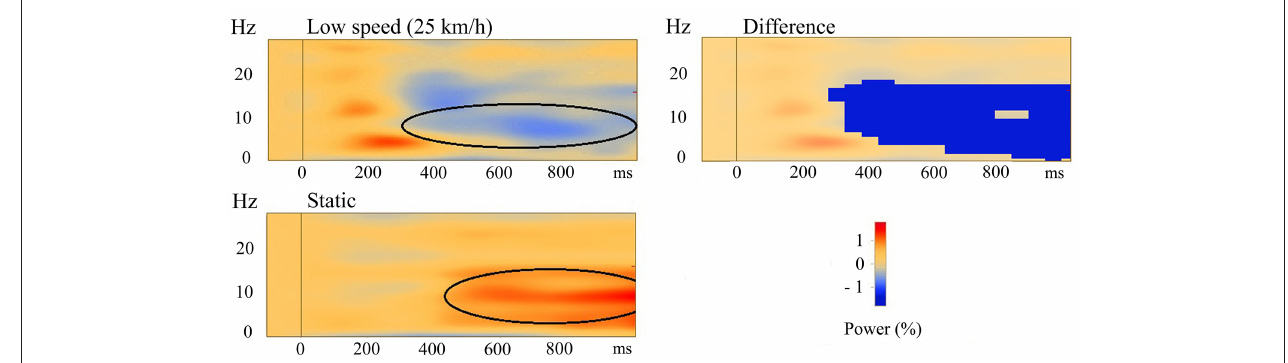
FIGURE 5 | Averaged TSE plots of all participants in the PM source. Top left is for the low speed condition, bottom left is for the static condition. Areas of de-synchronization (in blue) and synchronization (in red) are shown. Top right is the area of significant difference ( P < 0.05 ) between the low speed and the static condition. The dark blue area indicates that this difference was negative, meaning that the cluster values in the low speed condition (black oval in top left) were significantly lower than the cluster values in the static condition (black oval in bottom